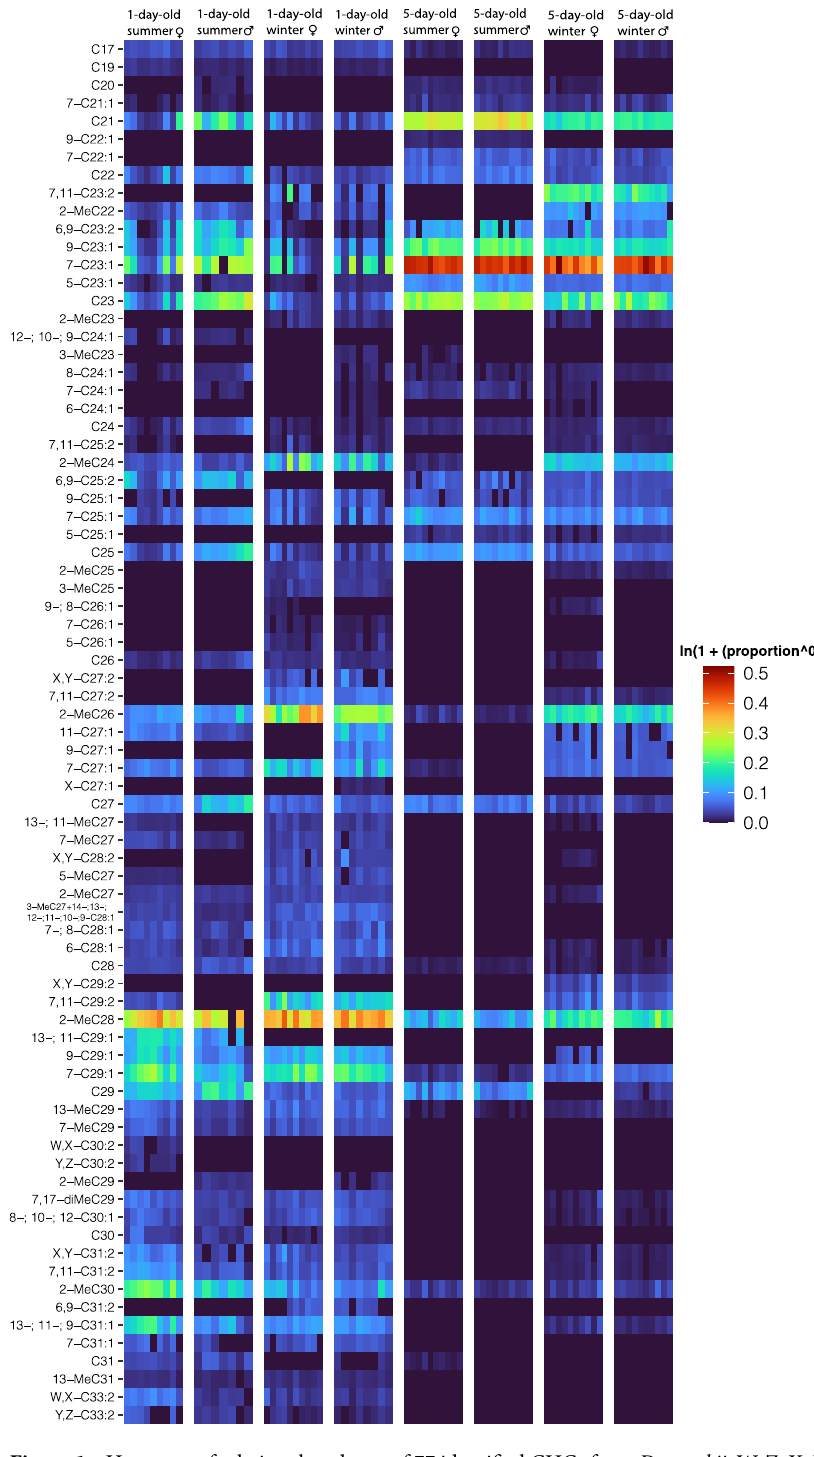
Figure 1. Heat map of relative abundance of 77 identified CHCs from D. suzukii. W, Z, X, Y—double bond position was not identified. Data were transformed ln(1 + (proportion^0.6)) and are displayed in colors ranging from dark blue (indicates 0) to dark red (indicates 0.5) as shown in the